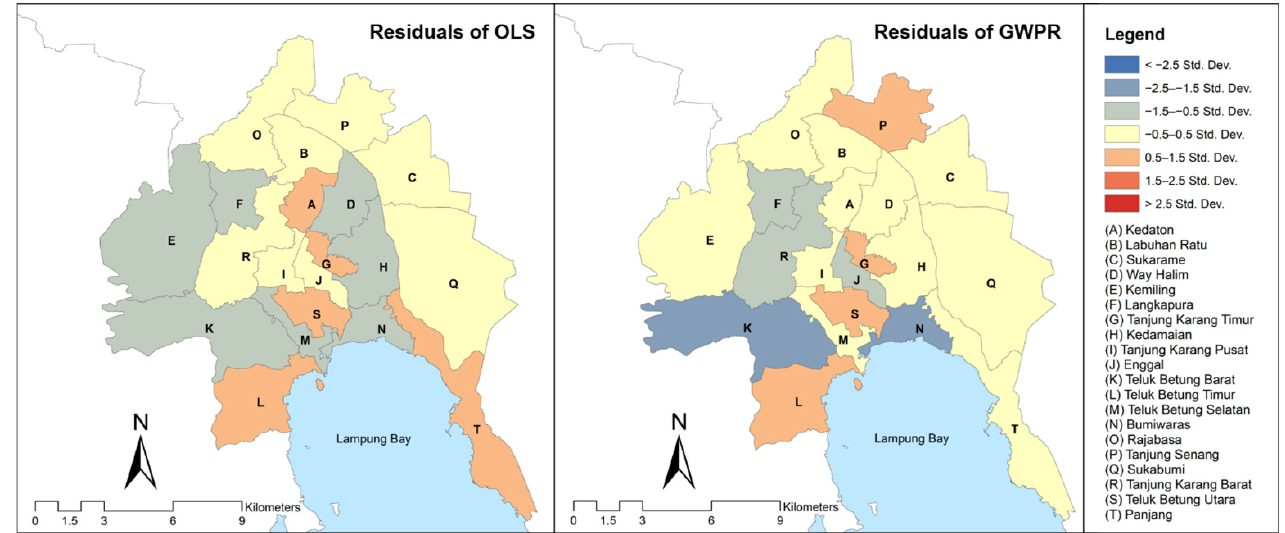
Figure 5. Residuals map of OLS and GWPR